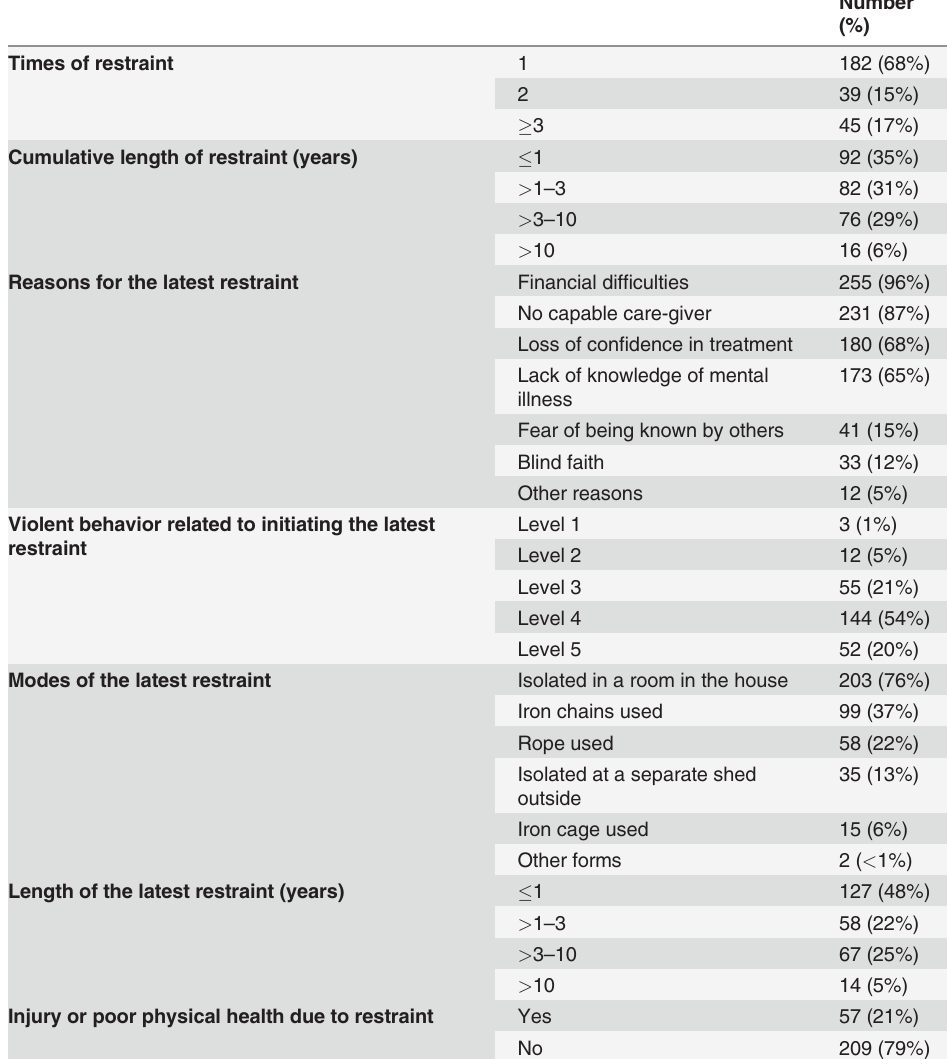
Table 2. Restraint history before being freed by 686 Program